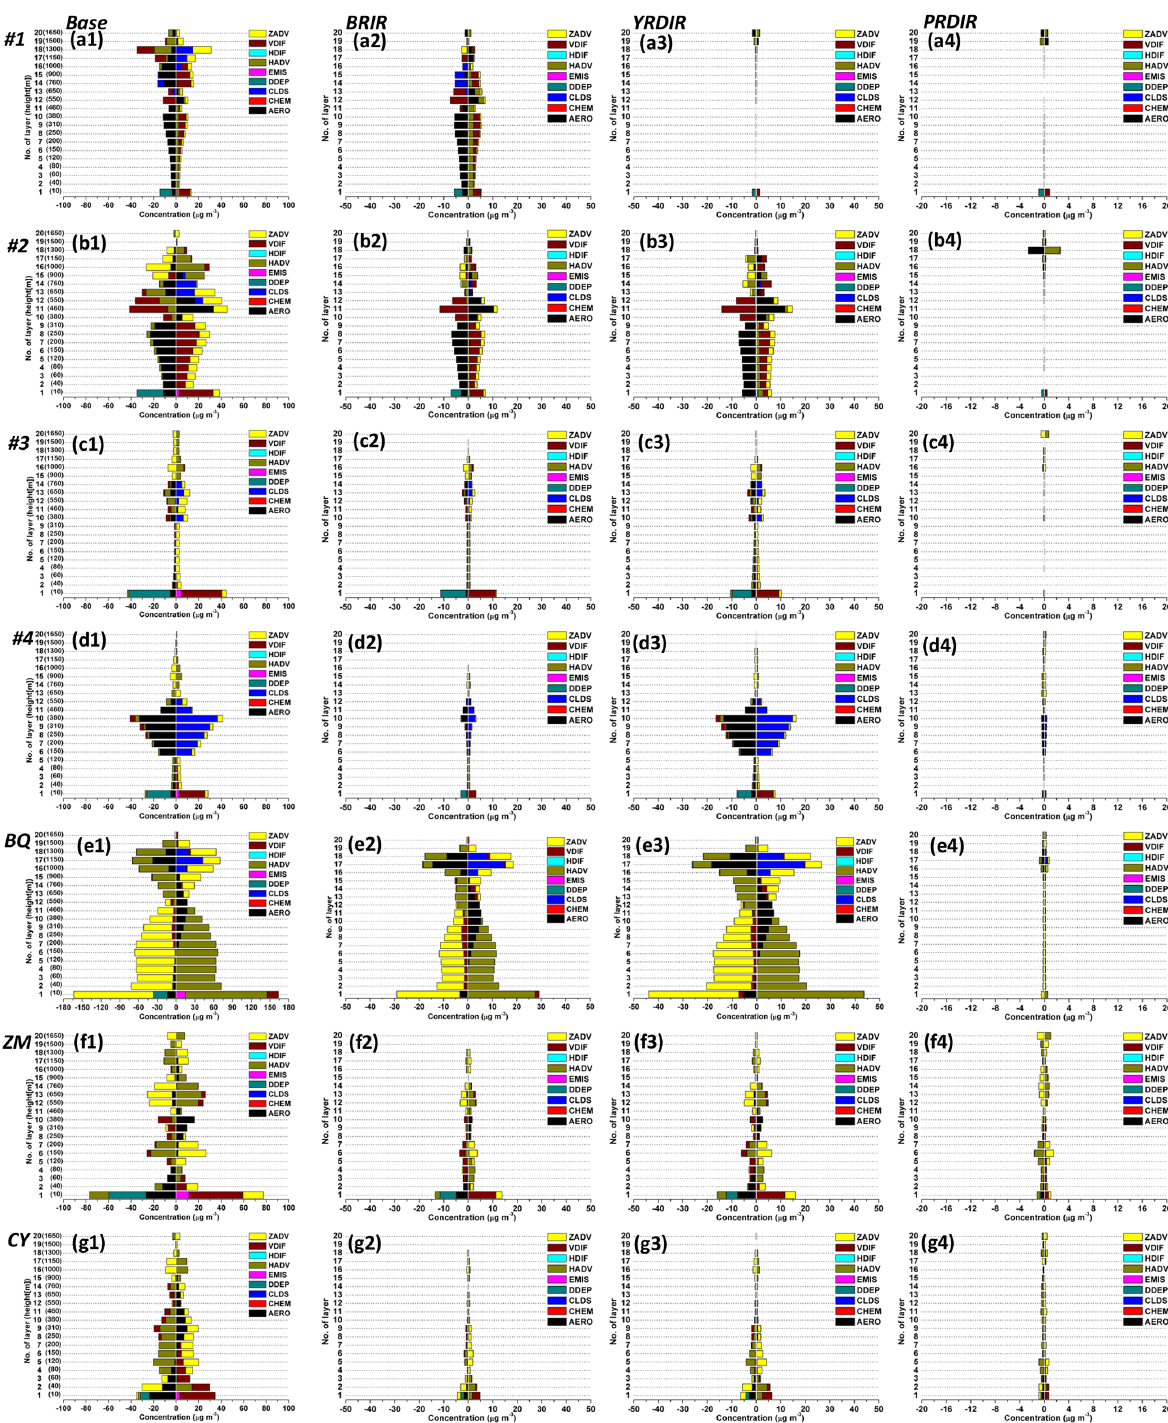
Figure 9. The hourly average contribution of the physical process at each layer on 9 January 2017. Panels (a) to (g) represent positions 1 to 4, BQ, ZM, and CY in Fig. 1, respectively. The influence of total emissions, BRIR, YRDIR, and PRDIR is represented in (1) , (2) , (3) , and (4) , respectively. The values in the brackets on y axes are the model heights of the lower 20